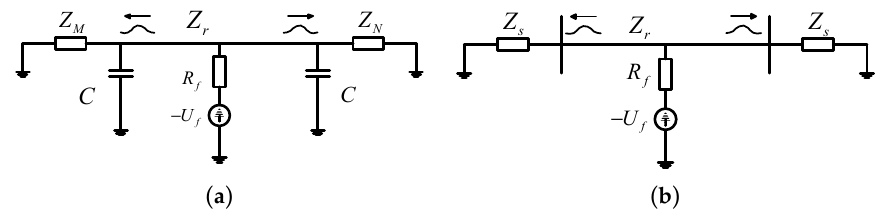
Figure 4. ( a ) Fault component additional network of Voltage Source Converter-High Voltage Direct Current (VSC-HVDC). ( b ) Simplified fault component additional network